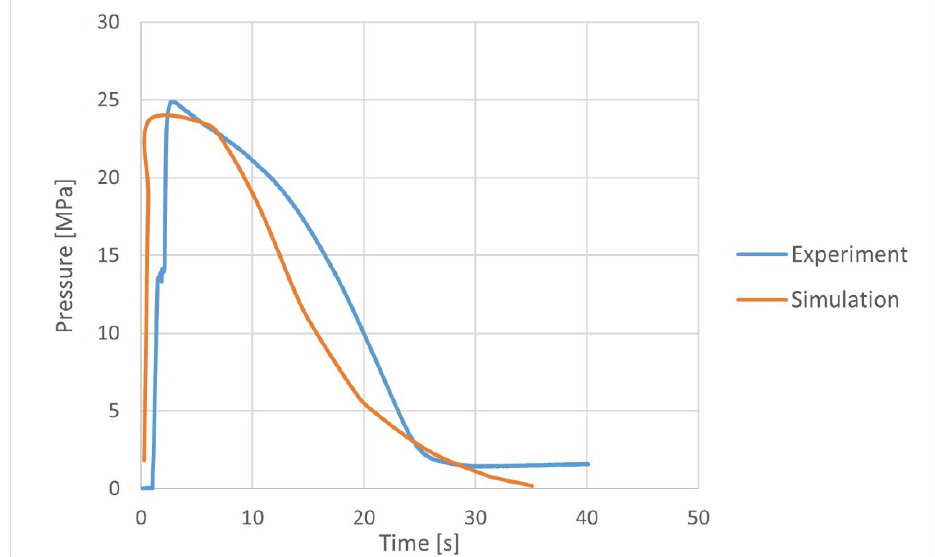
Figure 6. Comparison of cavity pressure profile from the experiment and numerical analyses.